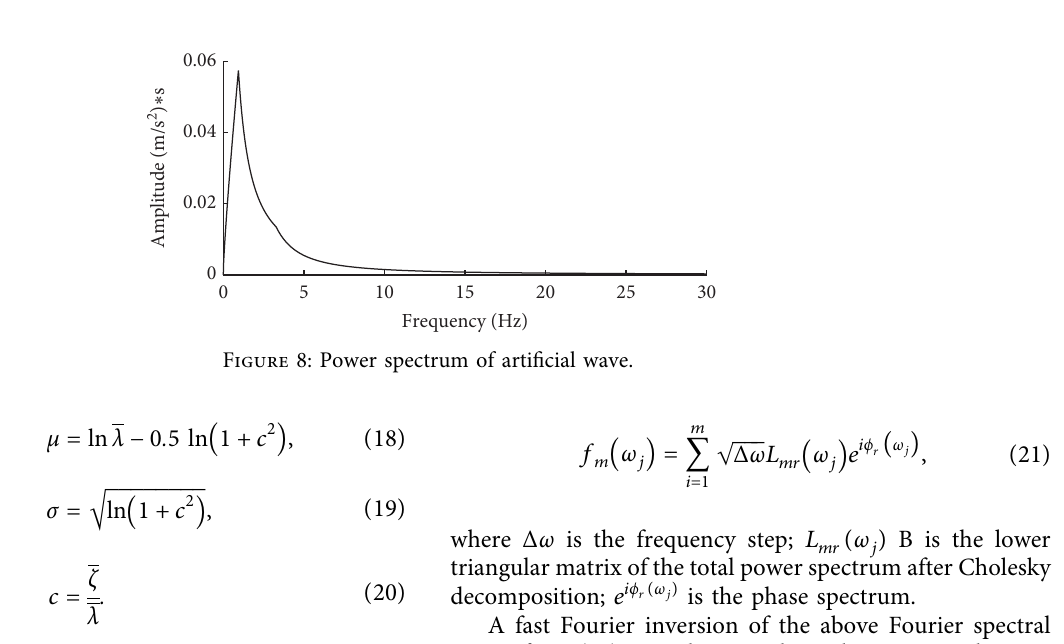
Figure 7: Multipoint excitation seismic wave synthesized based on specific seismic record. (a) EL-Centro wave; (b) Wenchuan wave.